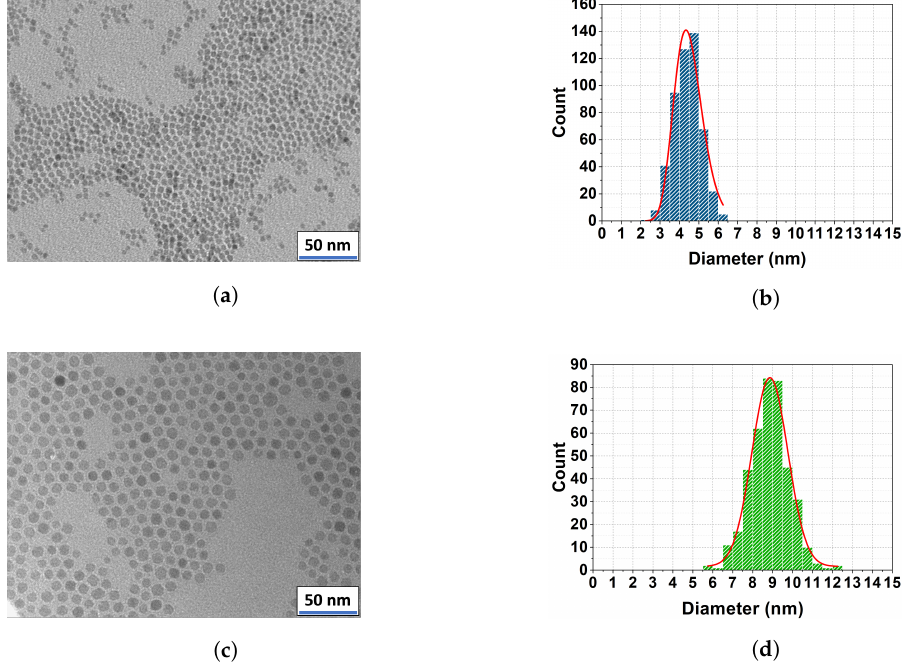
Figure 3. TEM images ( a , c ) and histograms ( b , d ) reporting the distribution of the core sizes for the first ( a , b ) and the second ( c , d ) set of nanoparticles coated with oleic acid. The distribution is fitted to a log-normal function; the mean value with the standard deviation are 4.4 ± 0.7 nm and 8.9 ± 0.9 nm,